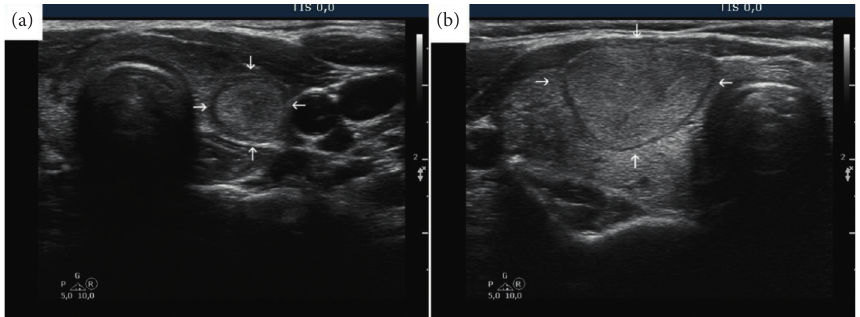
Figure 2: The importance of timely diagnosis of follicular thyroid cancer. (a) An EU-TIRADS score 3 nodule (arrows) with a maximum diameter of 12mm. According to EU-TIRADS, FNA is not indicated, and the diagnosis would have been missed. Final histology was minimally invasive follicular cancer restricted to the thyroid. (b) A 28mm follicular cancer (arrows) metastasizing to the lungs. The patient was first examined in another hospital 12 years earlier. At that time, the diameter of the nodule was 14mm, and FNA was not performed because of the absence of suspicious ultrasound characteristics.